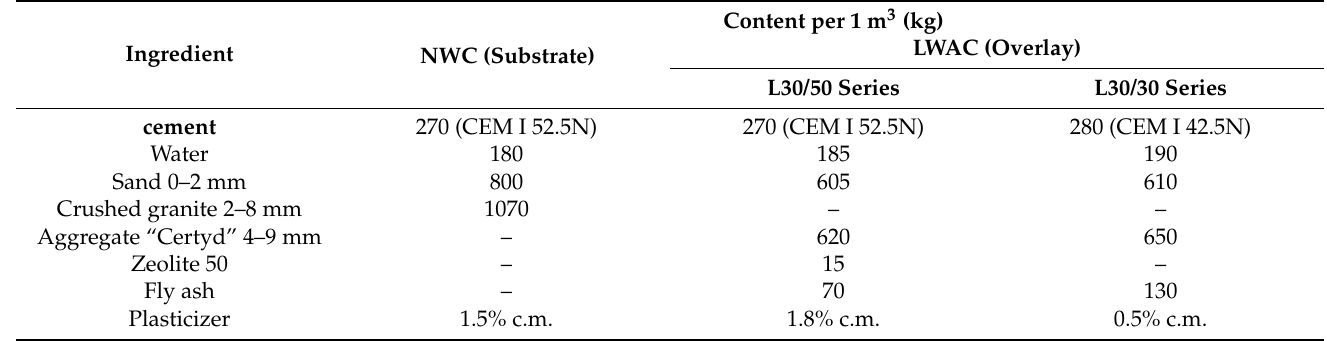
Table 6. Recipe of concrete mixes.